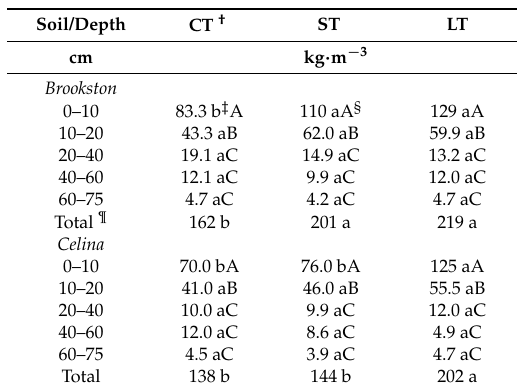
Table 3. Root dry weight per depth and total of alfalfa plants grown in a greenhouse for 180 days in intact cores of two Ohio soils treated with three levels of